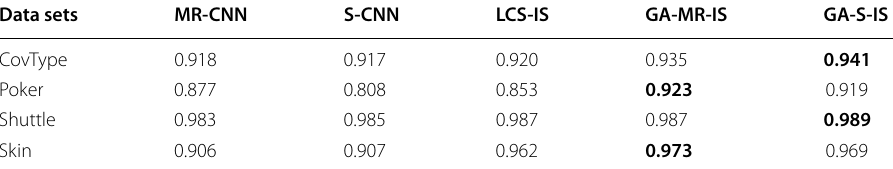
Table 7 The experimental results compared with three related methods on test accuracy Data sets